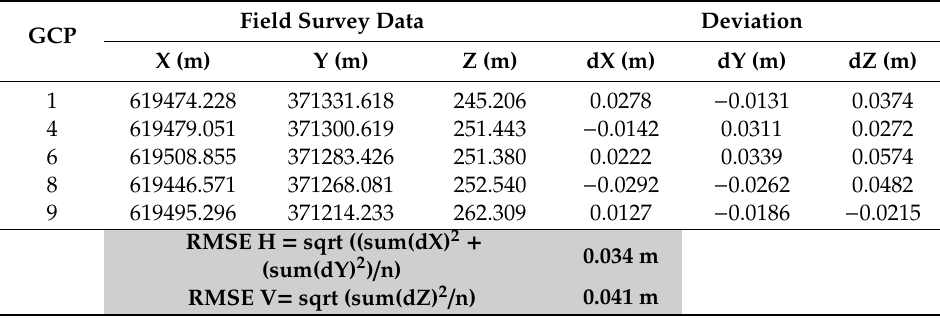
Table 2. UAV-SfM model accuracy assessment GCPs.